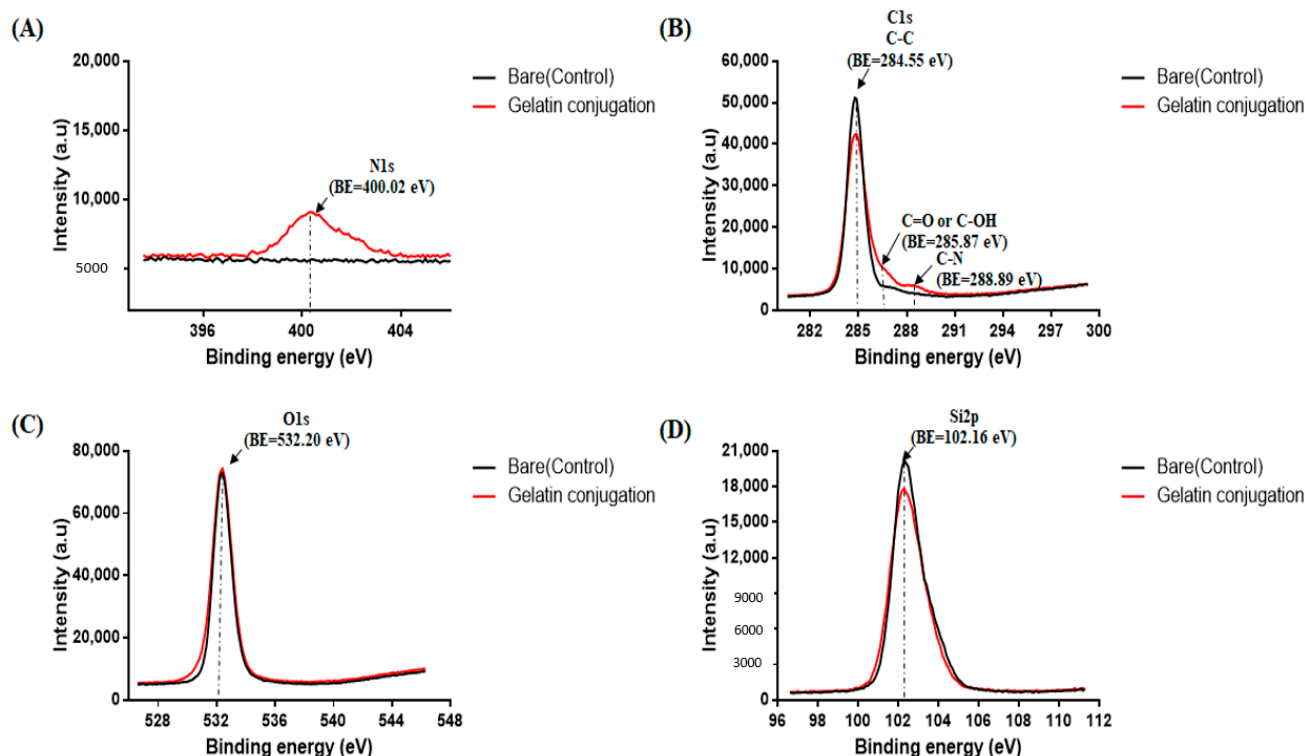
Figure 3. X-ray photoelectron spectroscopy (XPS) results of gelatin-conjugated poly(dimethylsiloxane) (PDMS) surface compared to those of bare PDMS. BE: binding energy. XPS elemental composition analyses in the regions of ( A ) N 1s (Nitrogen), ( B ) C 1s (Carbon), ( C ) O 1s (Oxygen) and ( D ) Si 2p (Silicon) on bare and gelatin conjugated PDMS.